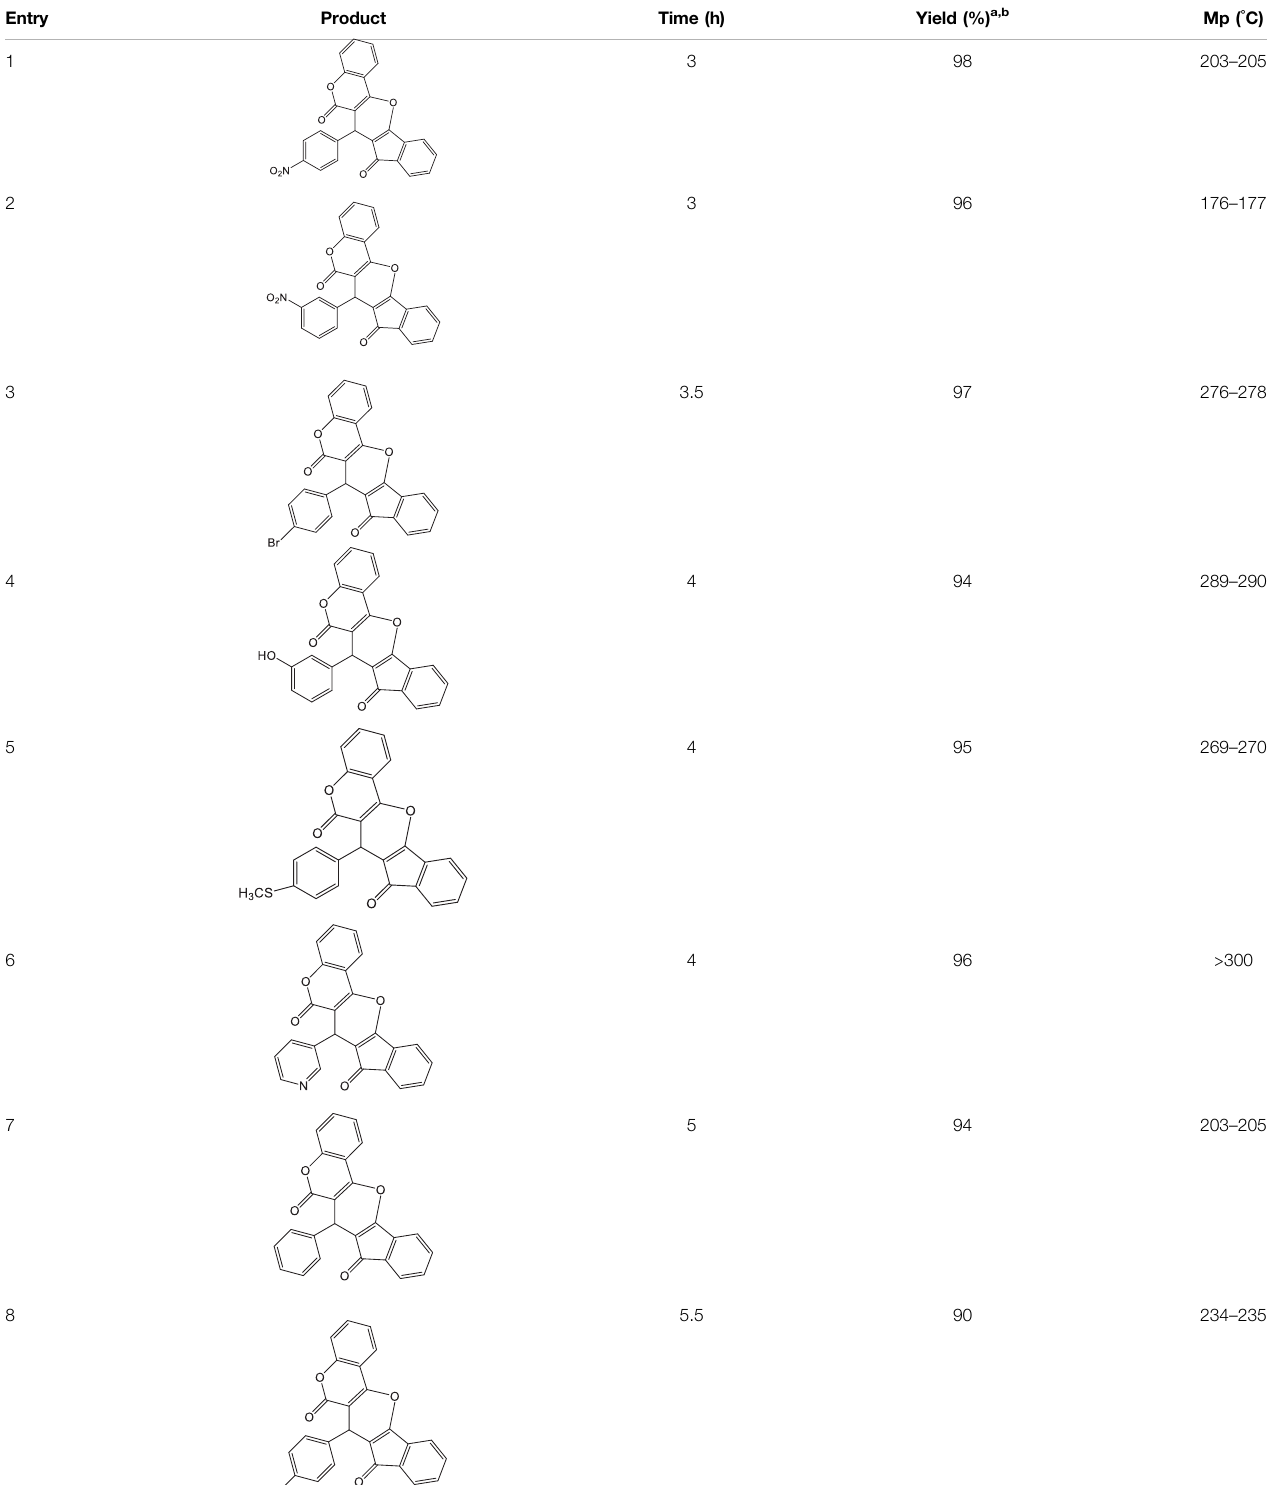
TABLE 2 | The reaction scope of synthesis of